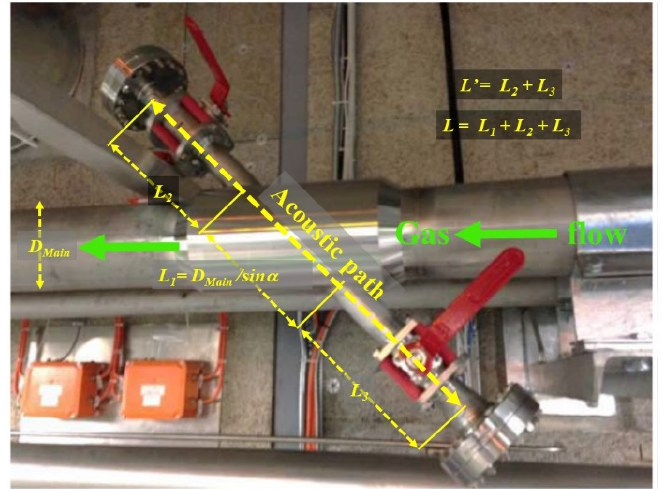
Figure 3. Angled ultrasonic flowmeter in the vapor return line of the ATLAS C 3 F 8 thermosiphon (‘TS’) recirculator.